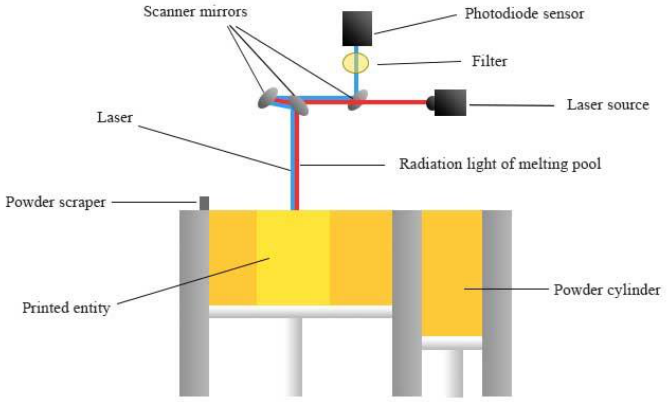
Figure 4. Schematic diagram of the online monitoring system of the melt pool.